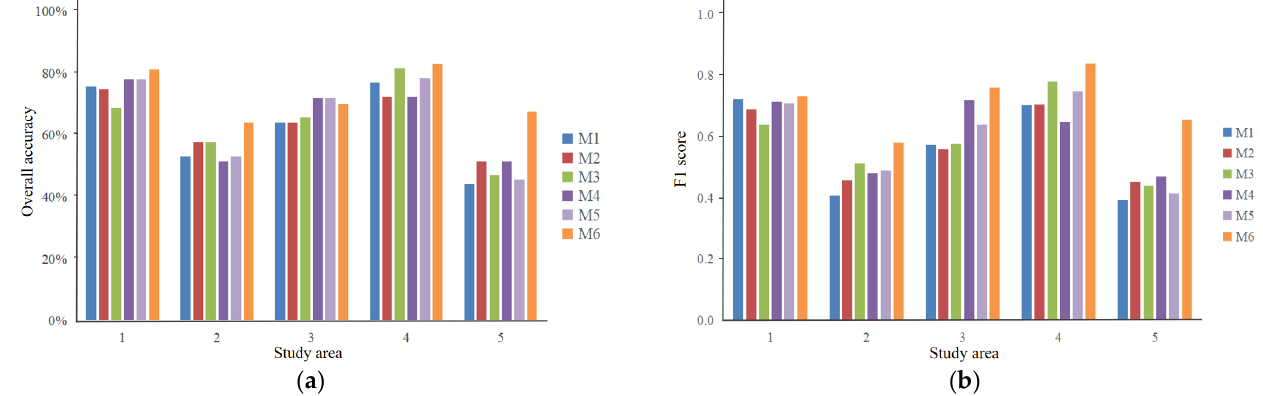
Figure 4. ( a ) Overall accuracy of each method; ( b ) F1 score of each method.